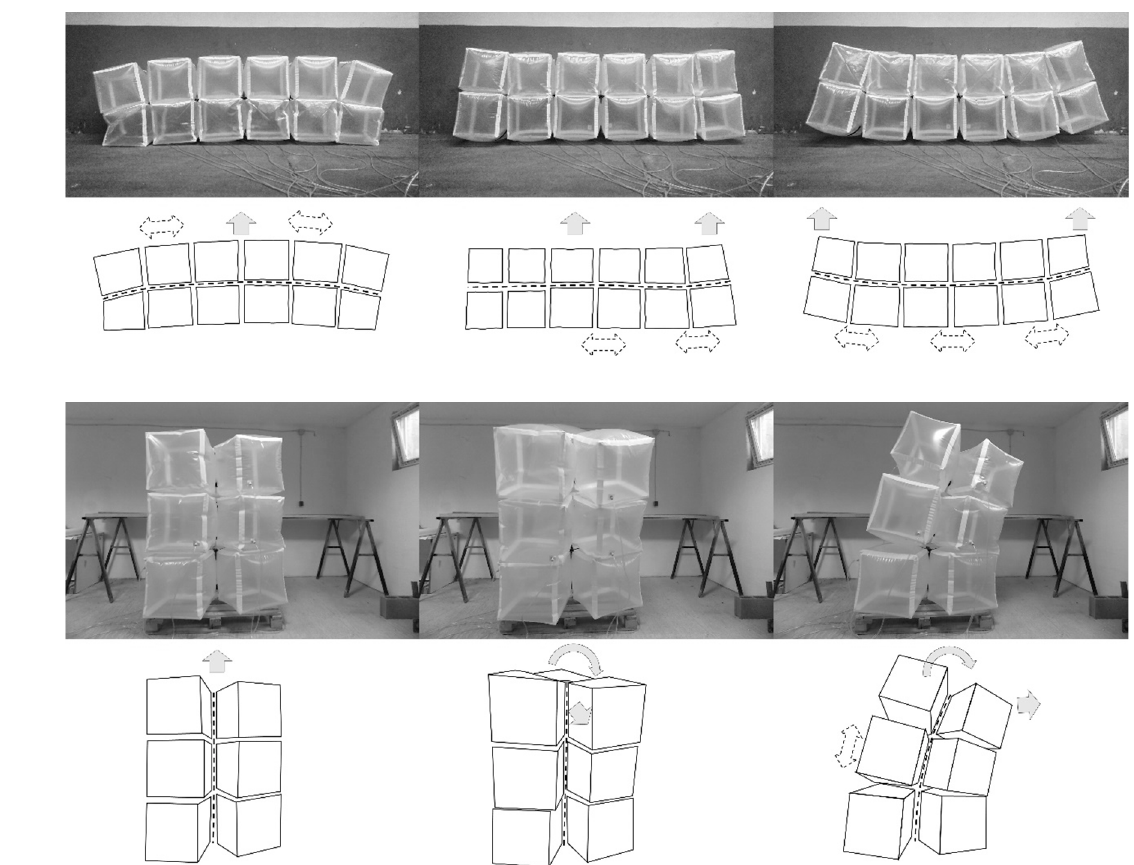
Figure 7. Basic body plan type C2: ( a ) Planar array; ( b ) Spatial array. Body plan type C3 was tested in two variants: 1) as a “tensairity”-like structure made